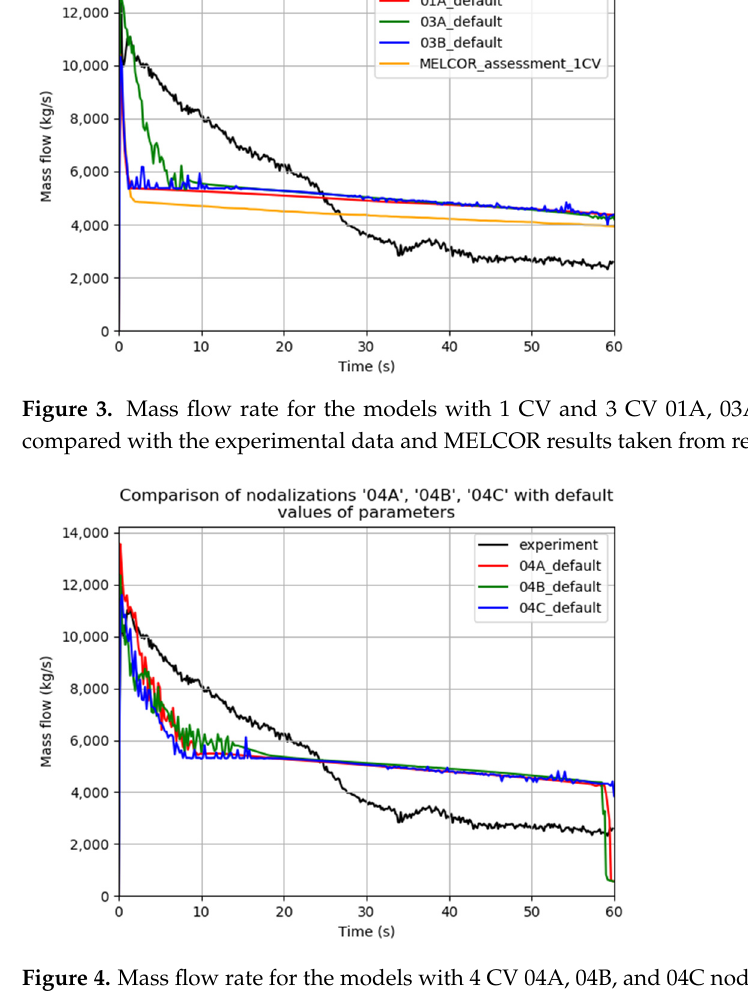
Figure 5. Mass flow rate for the models with 6, 8, and 9 CV 06A, 08A, and 09A nodalizations com- pared with the experimental data.